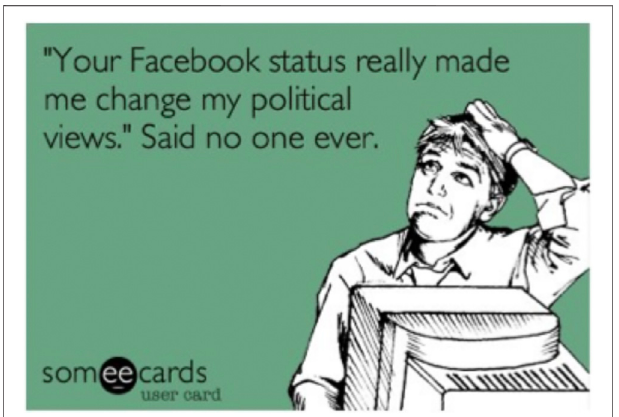
FIGURE 5 | An example of a Said no one ever